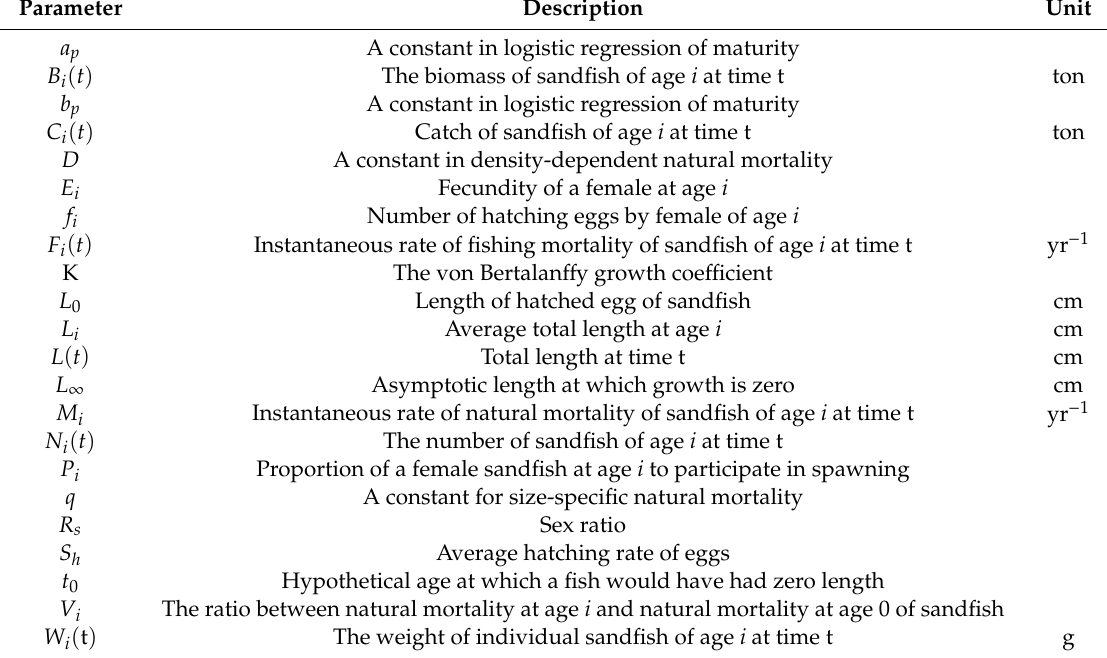
Table 1. Parameter and variables that are used in a stage-structured model for sandfish. Parameter